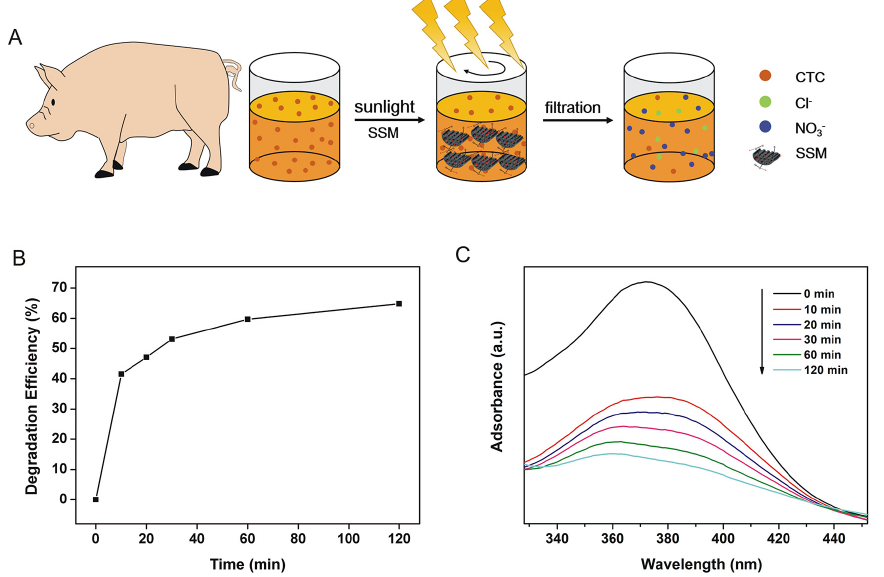
Figure 8. ( A ) Schematic diagram of CTC degradation process in swine urine aqueous solution by SSM; ( B ) DE of SSM (0.6 g/L) on CTC (20 mg/L) in swine urine/water solution with time under sunlight at room temperature; ( C ) UV–Vis spectra of the corresponding SSM-treated CTC swine urine/water solutions.